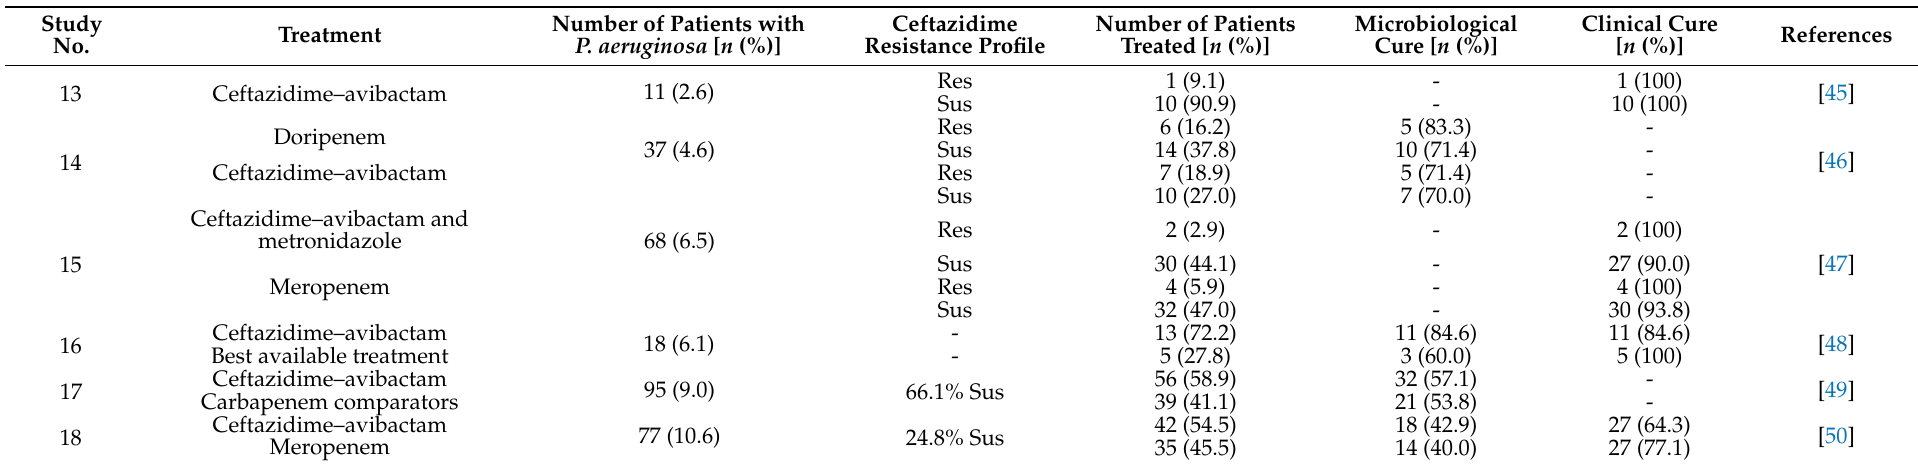
Table 6. Study findings from the supplementary ceftazidime–avibactam